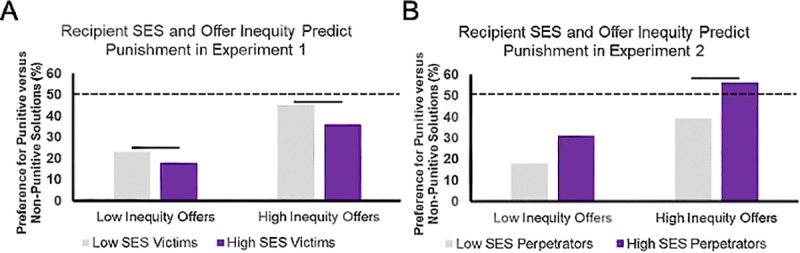
Percentage of decisions to punish by condition and experiment.The recipient’s and allocator’s SES levels were manipulated in separate experiments (panels A and B, respectively). For ease of interpretation, percentages from the raw count data are plotted rather than fitted log odds ratios. For this reason, error bars are not included in this figure. In both experiments, the percentage of decisions to punish (vs. not punish) perpetrators of selfish allocations is plotted as a function of ascribed SES (i.e., high, low) and offer inequity (i.e., highly selfish, less selfish). In Experiment 1 (A: n = 494), we observed greater punishment of perpetrators who allocated selfish offers to low-SES victims. This was especially pronounced when offers were highly selfish. In Experiment 2 (B: n = 505), we observed greater punishment of high-SES (vs. low-SES) perpetrators, but only when offers were highly selfish. Significant simple effects of SES are indicated with solid lines; all simple effects of offer inequity (i.e., contrasts of same-color bars) were significant (see Tables 1 and 3). The dotted line represents equal preference for punitive and non-punitive options—all conditions were significantly different from this line (see Tables 2 and 4).